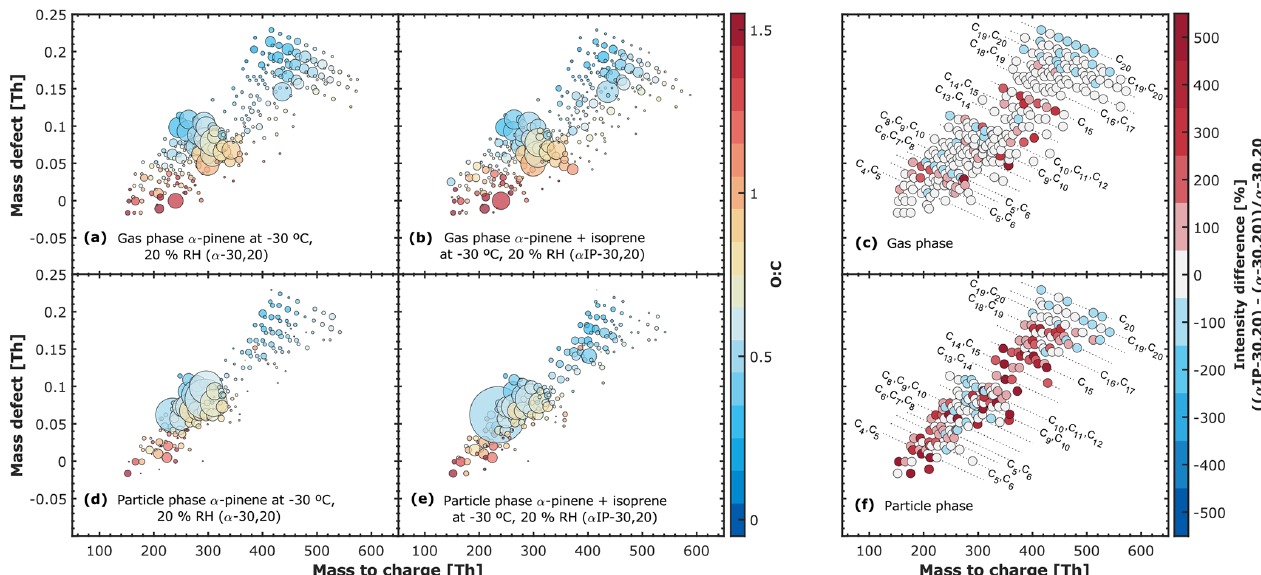
Figure 3. Mass defect plots of gas and particle phase and the intensity difference between each phase. Both phases are measured with a nitrate CI-APi-TOF mass spectrometer, while the TD-DMA is coupled to it for particle-phase measurements. (a) Gas and (d) particle phase for α -pinene oxidation products at − 30 ◦ C and 20% RH ( α -30,20). (b) Gas and (e) particle phase for α -pinene + isoprene oxidation products at − 30 ◦ C and 20% RH ( α IP-30,20). The level of α -pinene was between 1 and 8ppbv in both experiments, while isoprene was present only in experiment α IP-30,20 reaching up to 30ppbv. Ozone levels were ∼ 100 ppbv in both experiments. The symbol sizes in (a) , (b) , (d) , and (e) are the intensities normalized by the total signal in each system. The intensity difference in the gas phase (c) and in the particle phase (f) is indicated as (( α IP-30,20) − ( α -30,20)) /α -30,20. The color scale represents the difference in